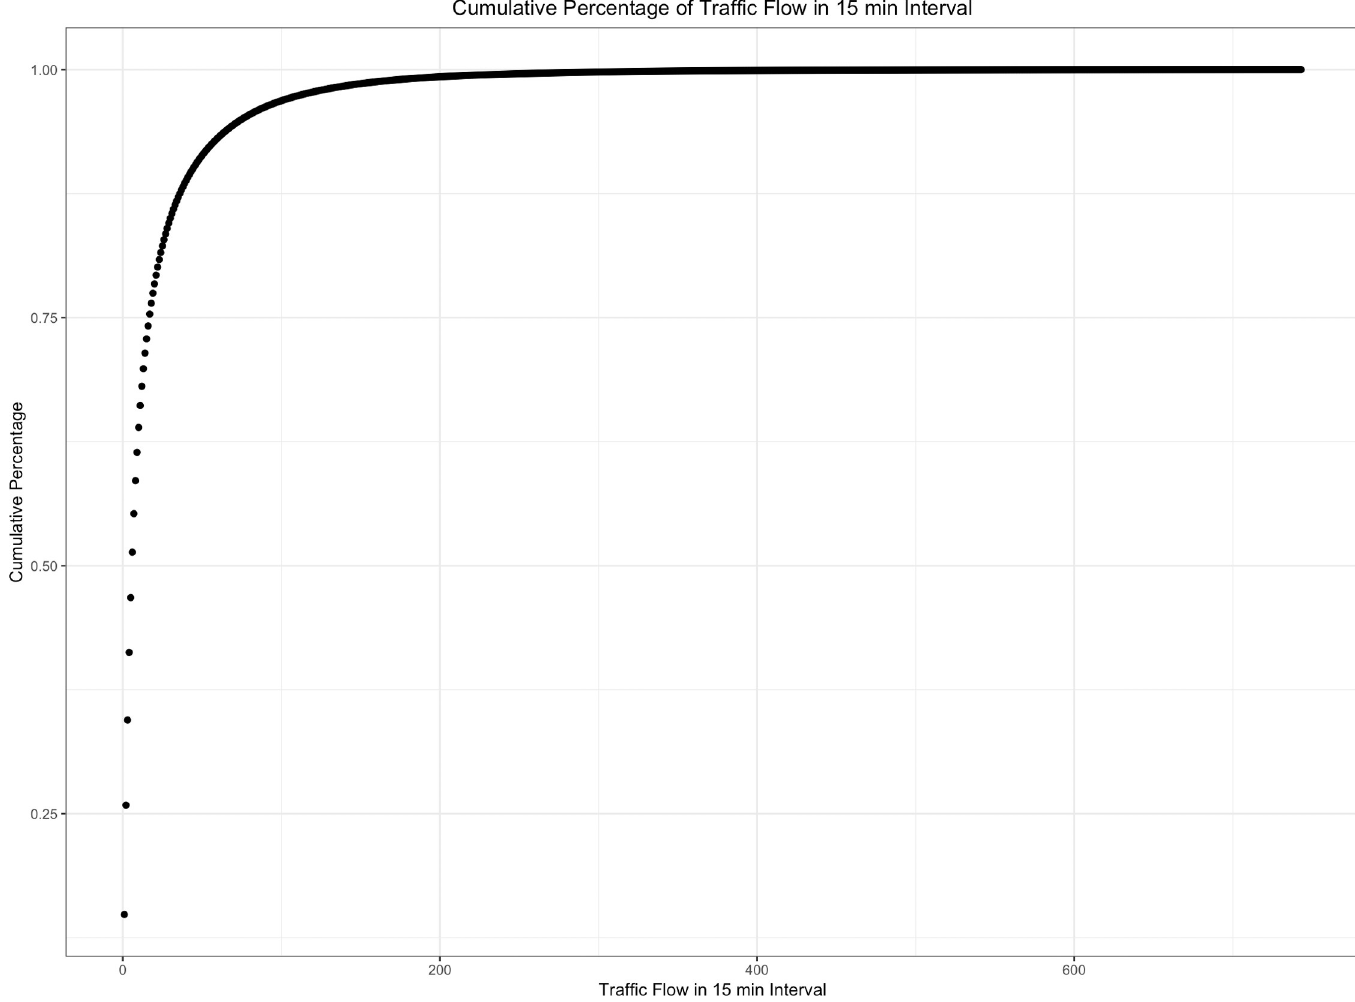
Fig 6. Cumulative flow distribution of OD pairs in